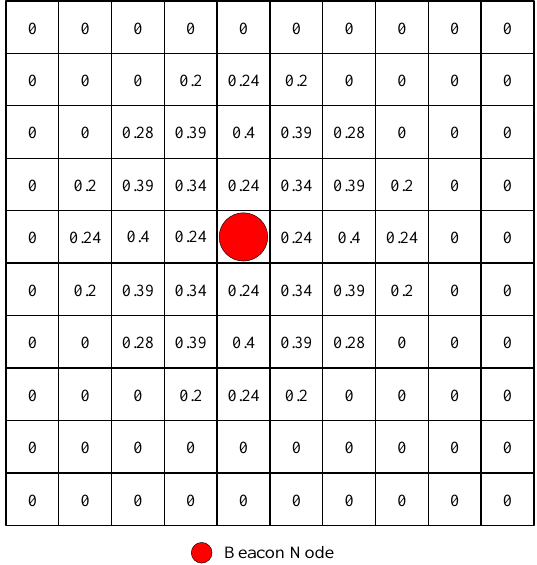
Figure 2. An example of voting process (only one beacon node).